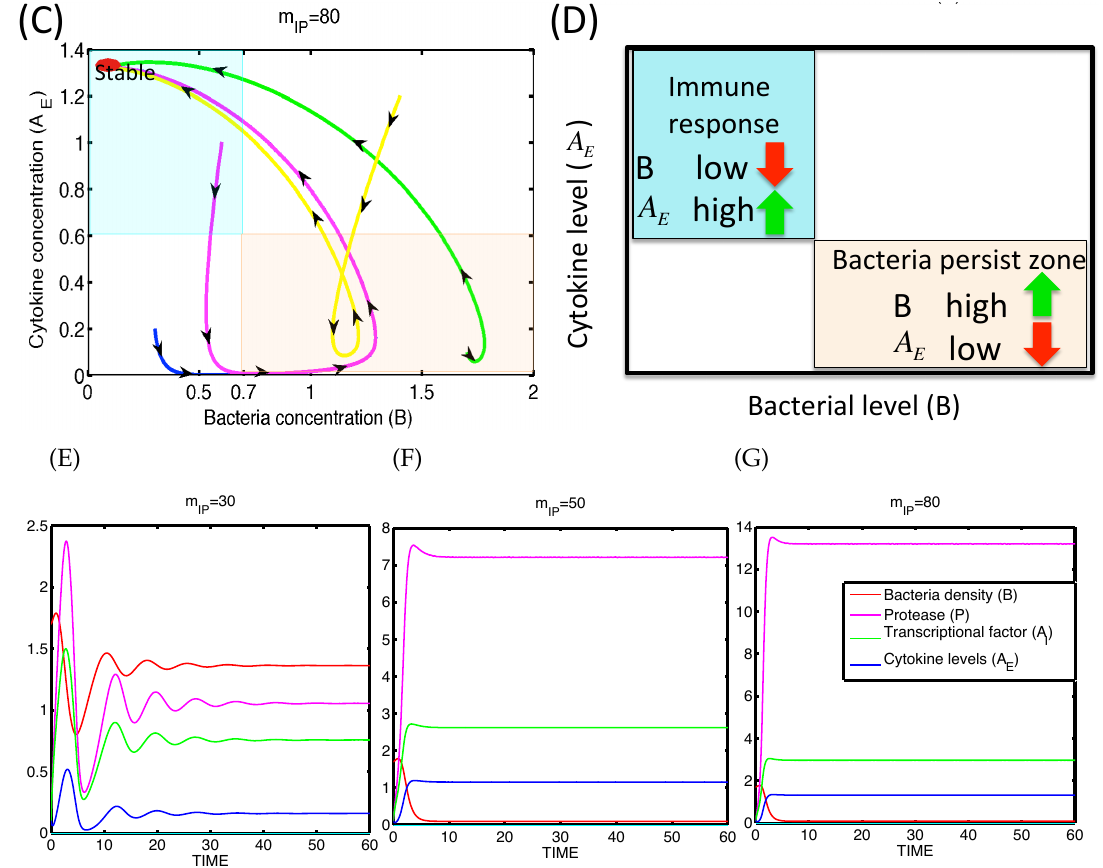
Figure 5. Dynamics of the M1 model (2). ( A – C ) Dynamics of the M1 system in the B - A E phase plane to a low ( m IP = 30; (A)), intermediate ( m IP = 50; (B)) and high ( m IP = 80; (C)) activation rate ( m IP ) of protease by the transcription factor. * Filled red circles in (A–C) = stable steady state (S.S.), empty black circle in (B) = unstable S.S. ( D ) A schematic of two adaptive types of bacterial infection systems (bacteria persist ( T B ) and immune boosting ( T I ) systems): T B = { ( B , A E ) ∈ R 2 : B > th B , 0 ≤ A E < th AE } , T = { ( B , A ) ∈ R 2 : 0 ≤ B < th > th } . All other parameters are fixed as in Table 1. I E B , A E AE ( E – G ) Time courses of the main variables ( B , P , A I , A E ) for various activation rates ( m IP = 30,50,80) with the initial condition: B ( 0 ) = 1.7, P ( 0 ) = 0.1, A I ( 0 ) = 0.1, A E ( 0 ) = 0.1. All other parameters are fixed as in Table